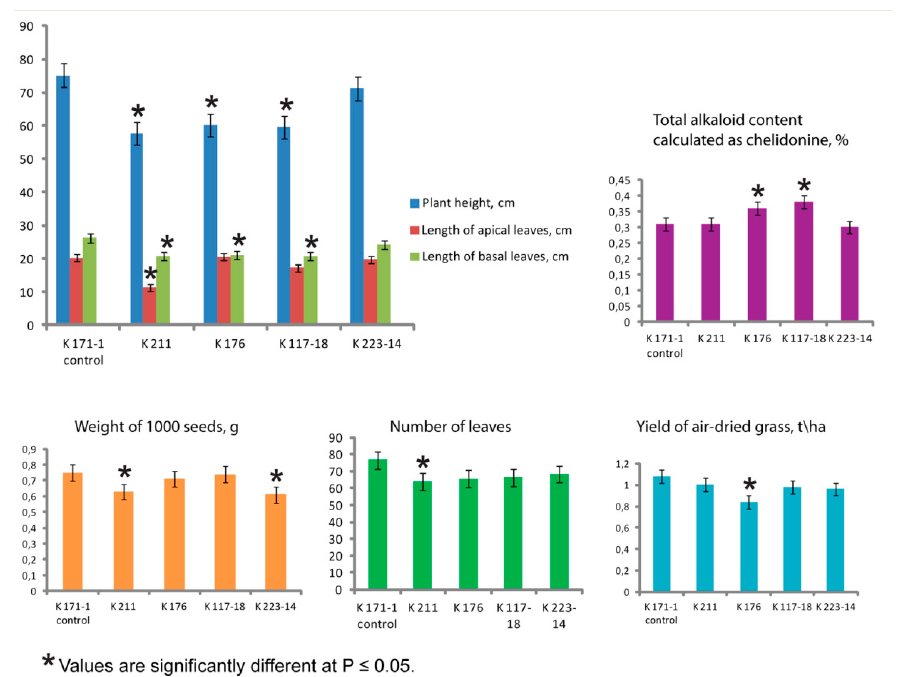
Figure 2. Bio-morphological traits of plants in the studied Chelidonium majus populations. Plant height (cm), length of apical and basal leaves (cm), total alkaloid content calculated as chelidonine (%), weight of 1000 seeds (g), number of leaves and yield of air-dried grass (t/ha) (the vertical axis) in the studied samples (the horizontal axis). Plants of the double-flowered sample ( К 211) displayed decreased length of apical leaves, number of leaves and number of flower spikes compared to plants of the control (K 171-1) sample having the same origin (Moscow region) as well as the other C. majus samples from other regions (Figure 2). The mean values of yields of air-dried grass varied from 0.84 to 1.08 t/ha, and the control sample ( К 171-1) had the highest yield (1.08 ± 0.11 t/ha). Also, the plants of this sample produced the most leaves (76.50 ± 4.75) (Figure 2). Values of seed yields were rather high in all populations (Table 2). At the same time, plants of the studied C. majus samples differed in the value of weight of